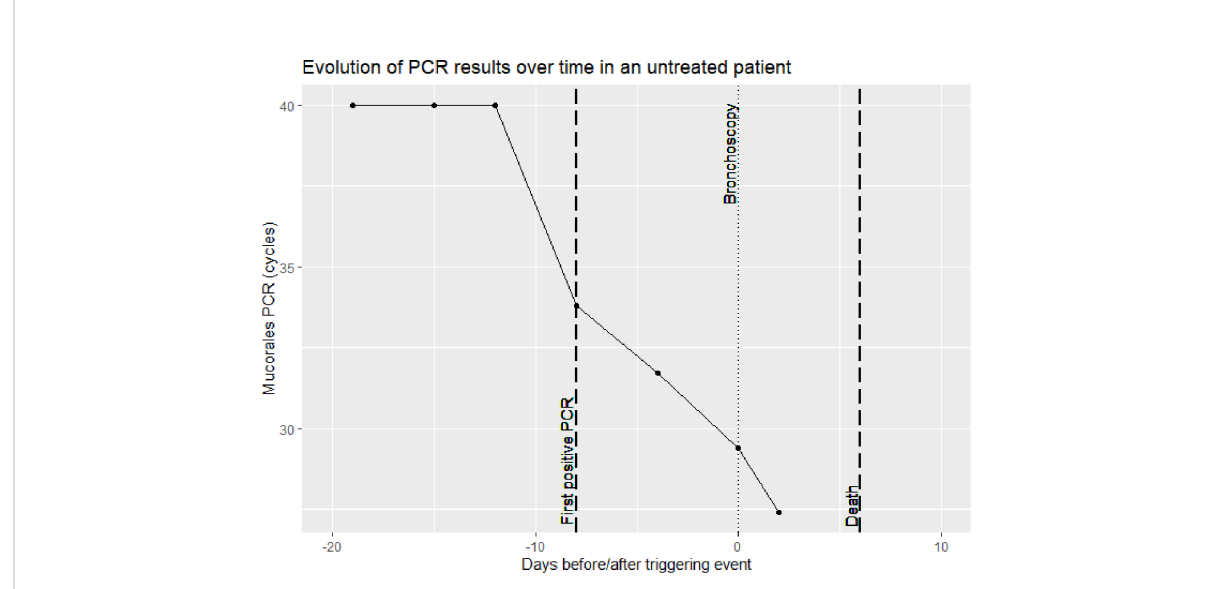
FIGURE 3 Overview of Mucorales PCR results in serial serum samples of a patient not receiving anti-mold